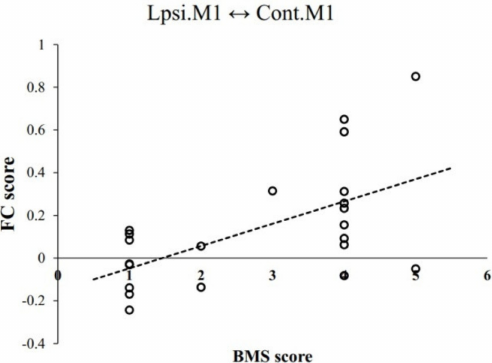
Figure 3. FC between ipsilesional and contralesional M1 is positively correlated with prognosis of hand function, as evaluated by Brunnstrom motor stages (BMS) (r = 0.581, p = 0.005). Good and poor recovery outcomes based on the Brunnstrom stage of upper-limb function at 6 months were determined as the standard, and the ROC curve indicated that a cuto ff score of 0.013 had the greatest prognostic ability (maximum sensitivity and specificity) (Figure 4). The sensitivity of this model for predicting good recovery was 81.8% and the specificity was 63.6%. AUC value was 0.793, which is a fair level.